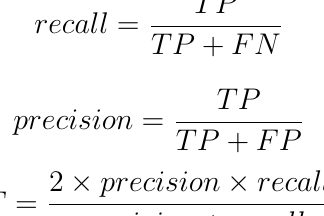
Table 1. Confidence values C